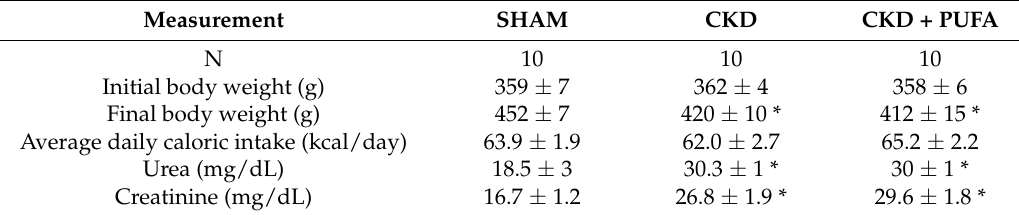
Table 1. Body weight, calorie intake and renal function parameters in sham-operated (SHAM), 5/6 nephrectomized rats fed with standard diet (chronic kidney disease; CKD) and fed with n 3-polyunsaturated fatty acids (PUFA) enriched diet (CKD + PUFA). * p < 0.05 vs. SHAM Measurement